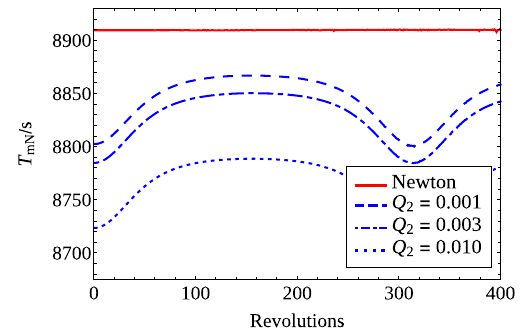
Fig. 9 Evolutionoftheorbitalperiodof Saround P(inseconds)during the first 400 revolutions for different values of Q 2 in the mN-potential, and constant Q 3 = 0 . 2 μ m and Q 4 = 1 μ m 2 . We observe the Q 2 term has no measurable effect in the precession, that is due to non-vanishing Q 3 and Q 4 . However, it reduces the period of S, as it acts as an effective increase of the gravitational constant, G N → G N ( 1 + Q 2 ) . In solid red, we depict the constant Newtonian